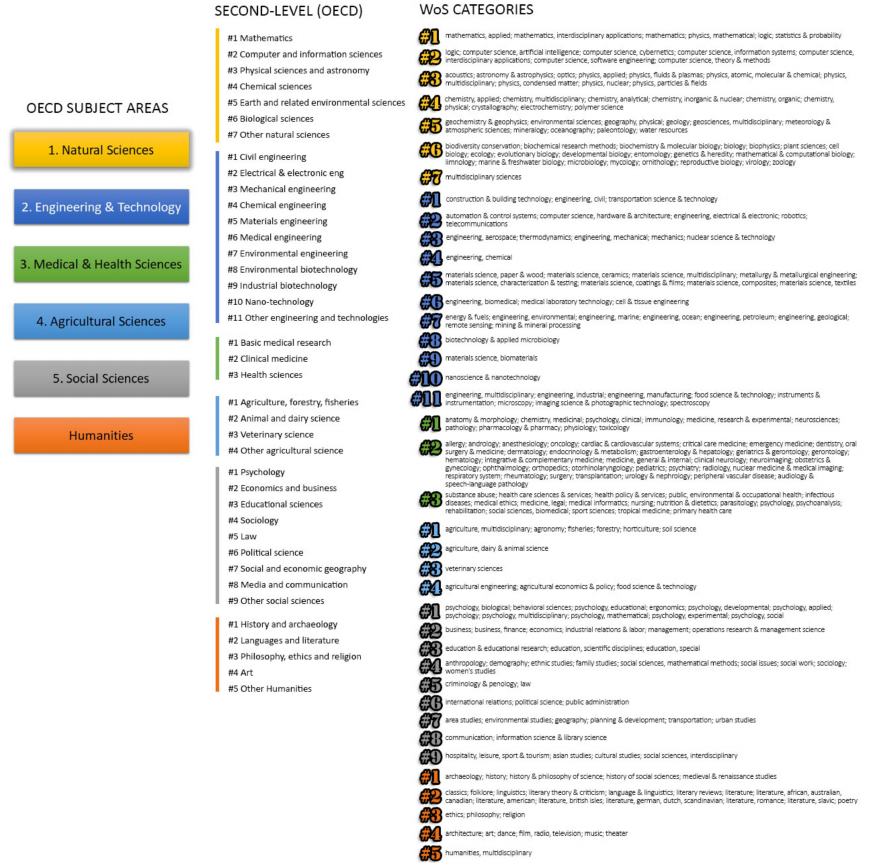
Figure A1. OECD-WoS subject classification scheme (high-resolution image: http: // zehrataskin.com / MDPI_Information /